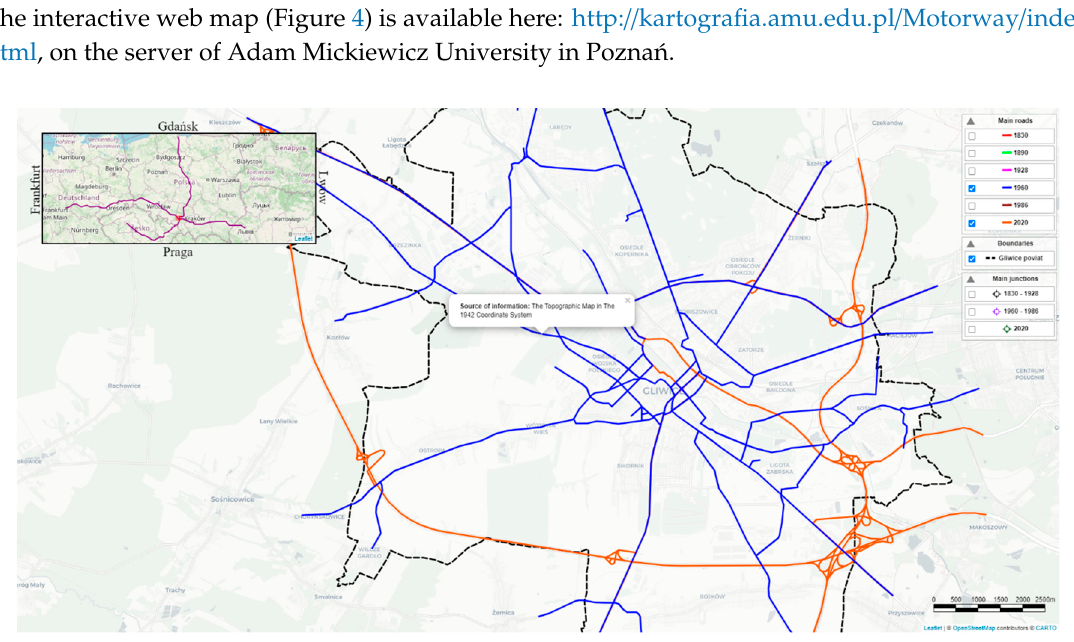
Figure 4. Interactive web map of the development of the European freeway junction A1/A4.